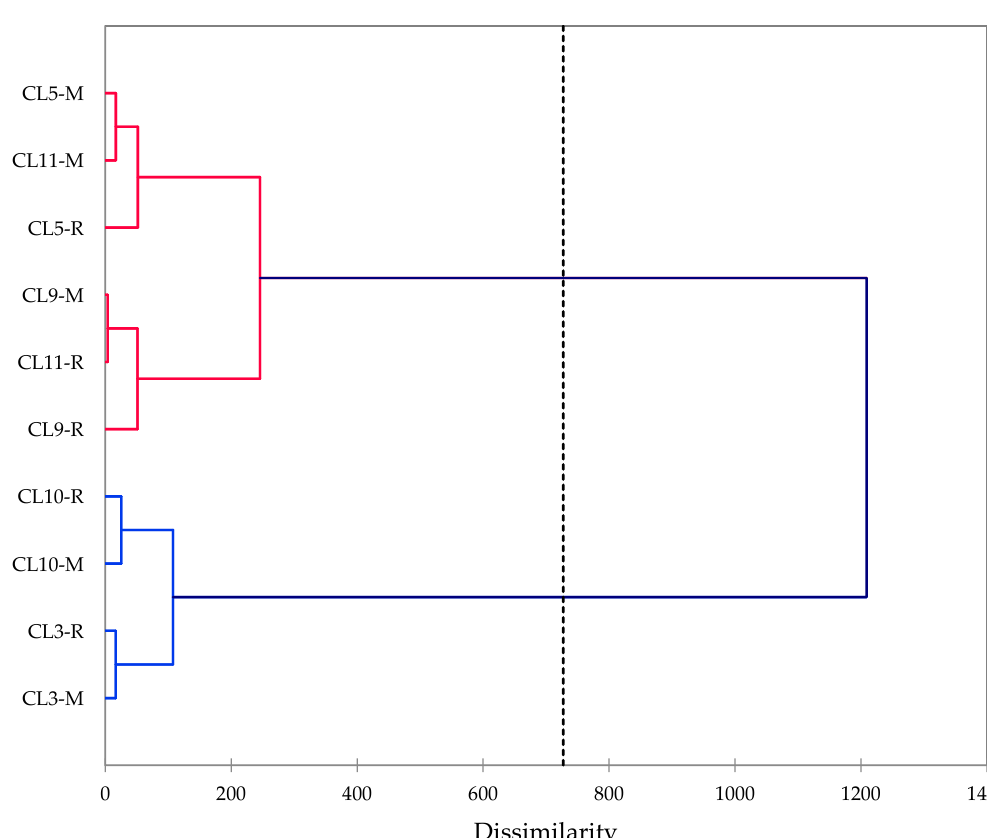
Figure 2. Dendrogram obtained from agglomerative hierarchical cluster analysis of the rhizome essential oils from varieties of Curcuma longa cultivated in north Alabama.